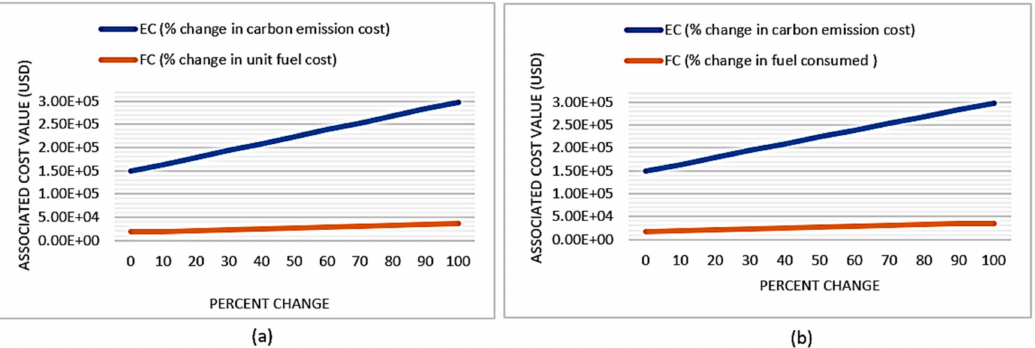
Figure 14. Sensitivity analysis of ( a ) change in emission cost (EC) and change in unit-fuel cost (FC) and ( b ) change in emission cost (EC) and fuel consumed by truck / km (FC